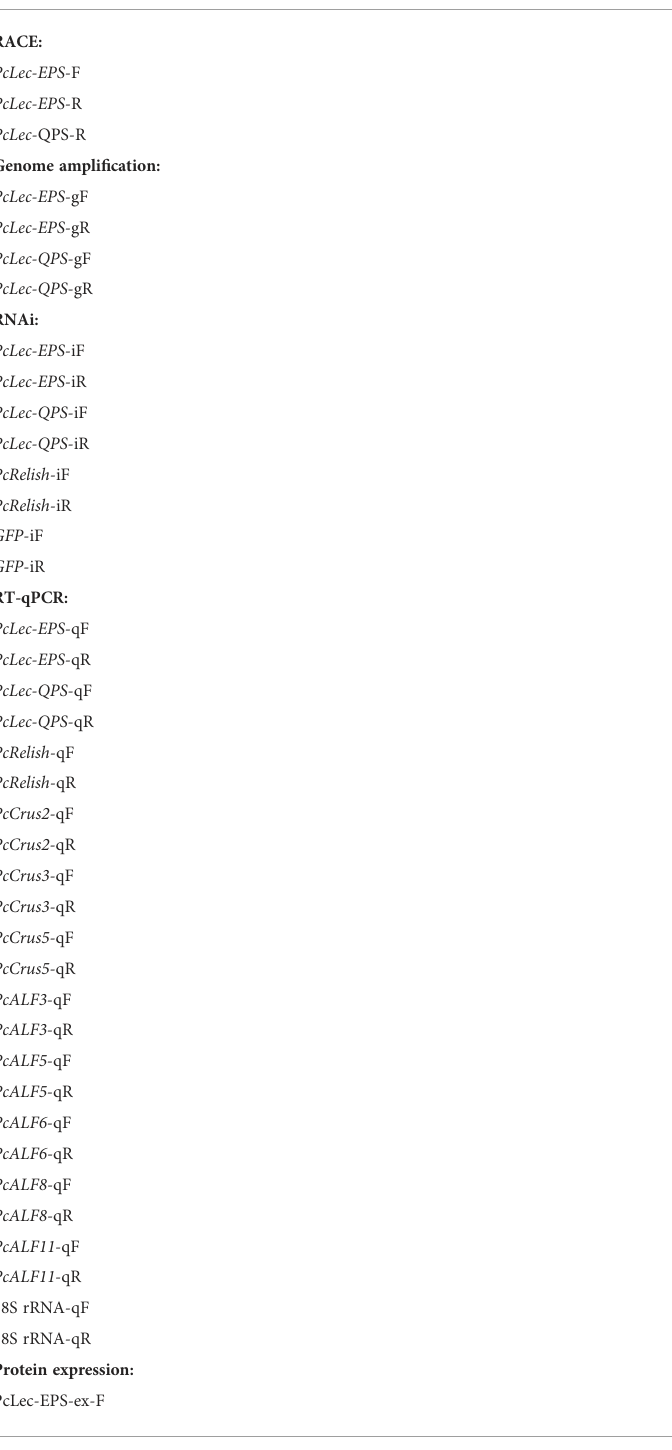
TABLE 1 Sequences of the primers used in this study. Primers